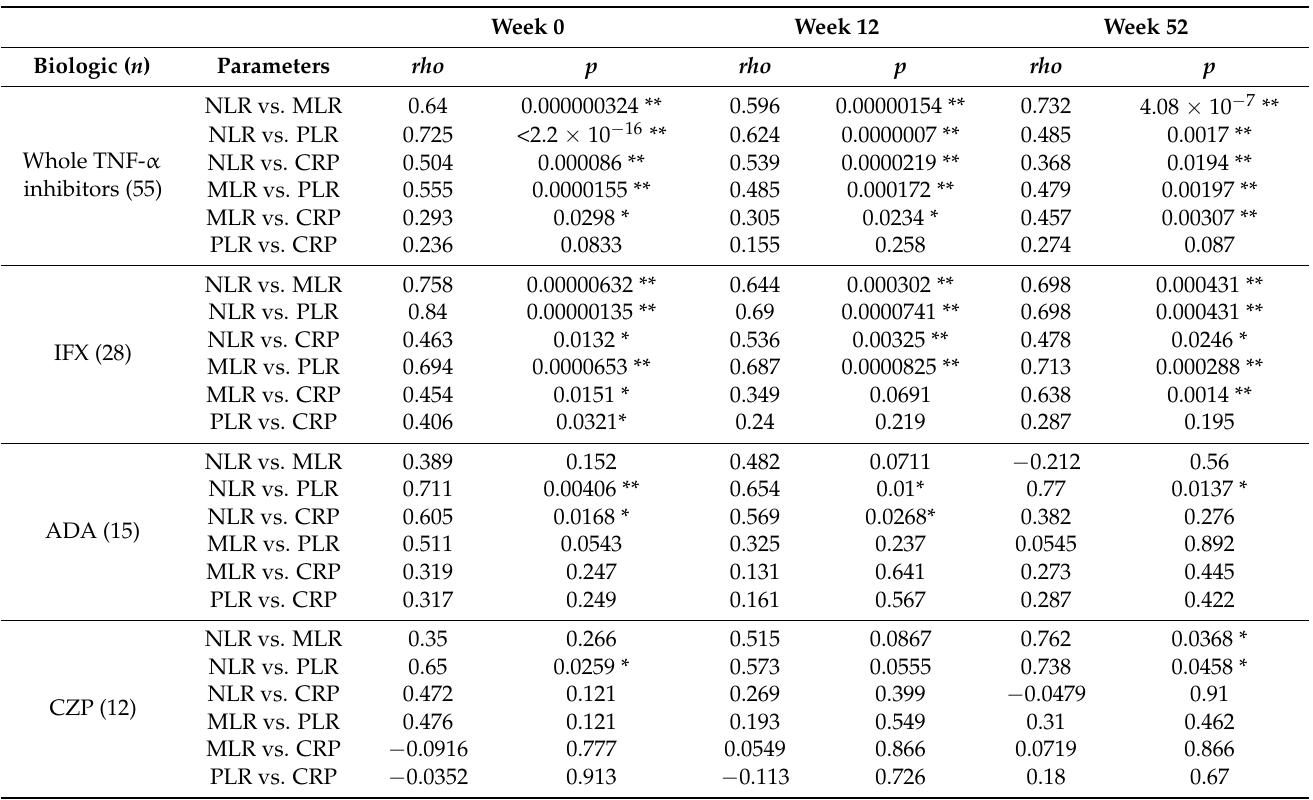
Table 3. Correlations between individual laboratory